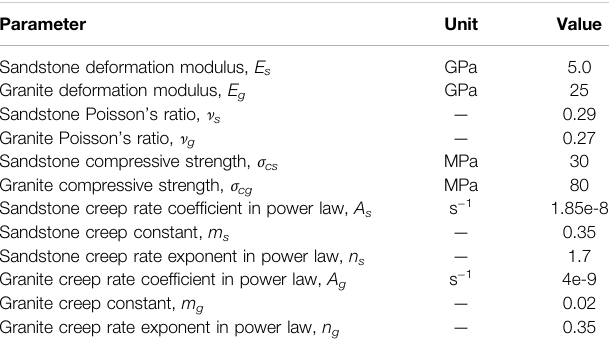
TABLE 1 | Mechanical parameters of numeral